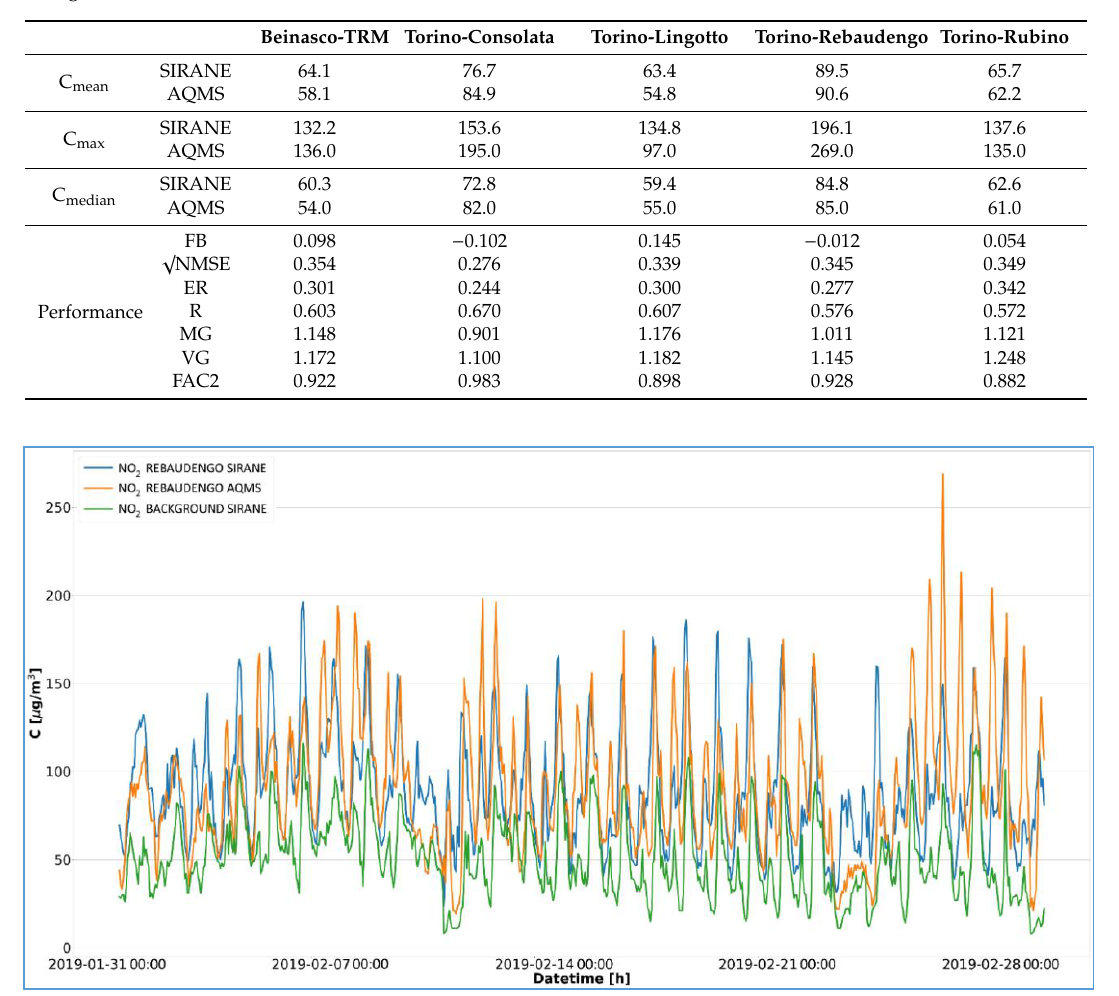
Figure 8. Statistical distribution of average NO 2 concentrations modelled by SIRANE (_Mod) and measured by tubes (_Mes) at receptors using boxplot (left) and scatterplot (right) for the campaign period (elaboration by means of MiniTab ® 17.1.0 and Python 3.6.5).